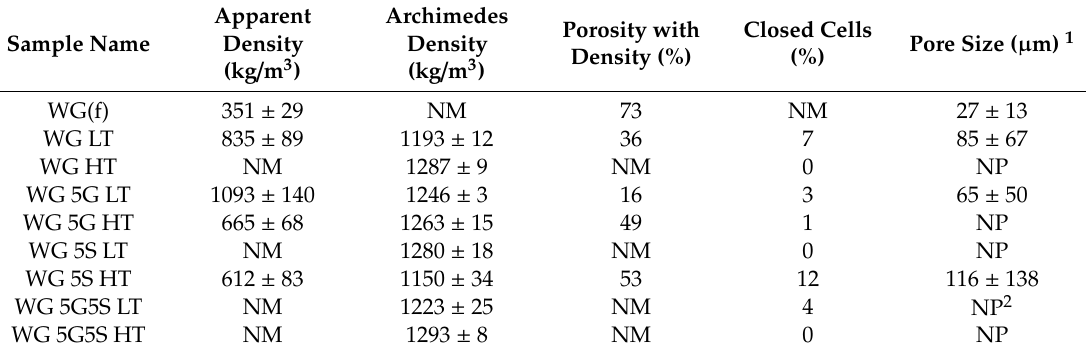
Table 2. Physical properties of the di ff erent